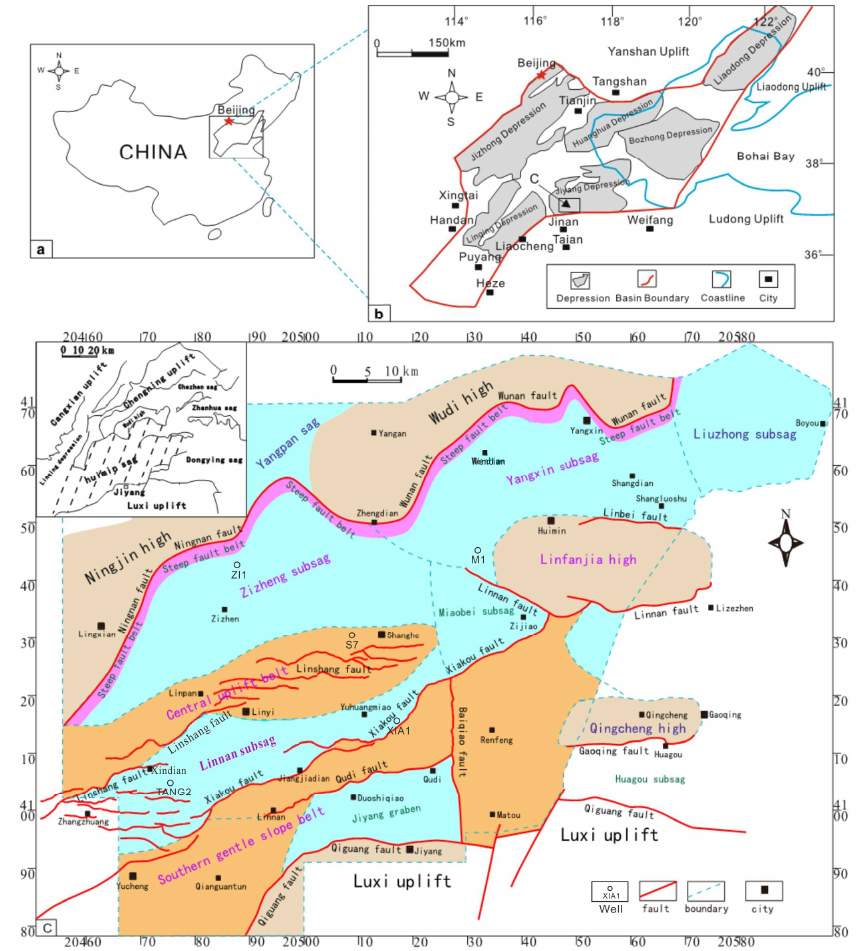
Figure 2. A map showing ( a ) the location of the Bohai Bay Basin and ( b ) the boundaries of the Huimin depression. ( c ) A map showing the structural unit divisions of the Huimin depression and the dashed area in the upper left corner is a thumbnail of the map [25].